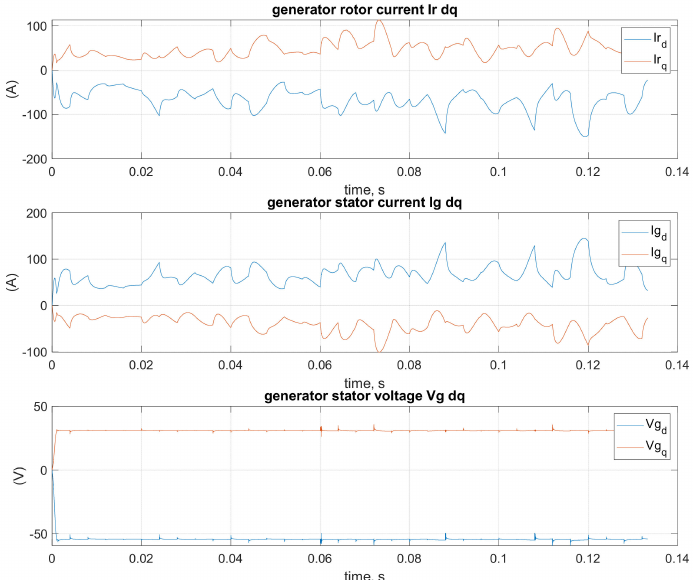
Figure 5. Stator voltage V g and stator and rotor currents I g and I r of the DFIG generator in dq coordinate